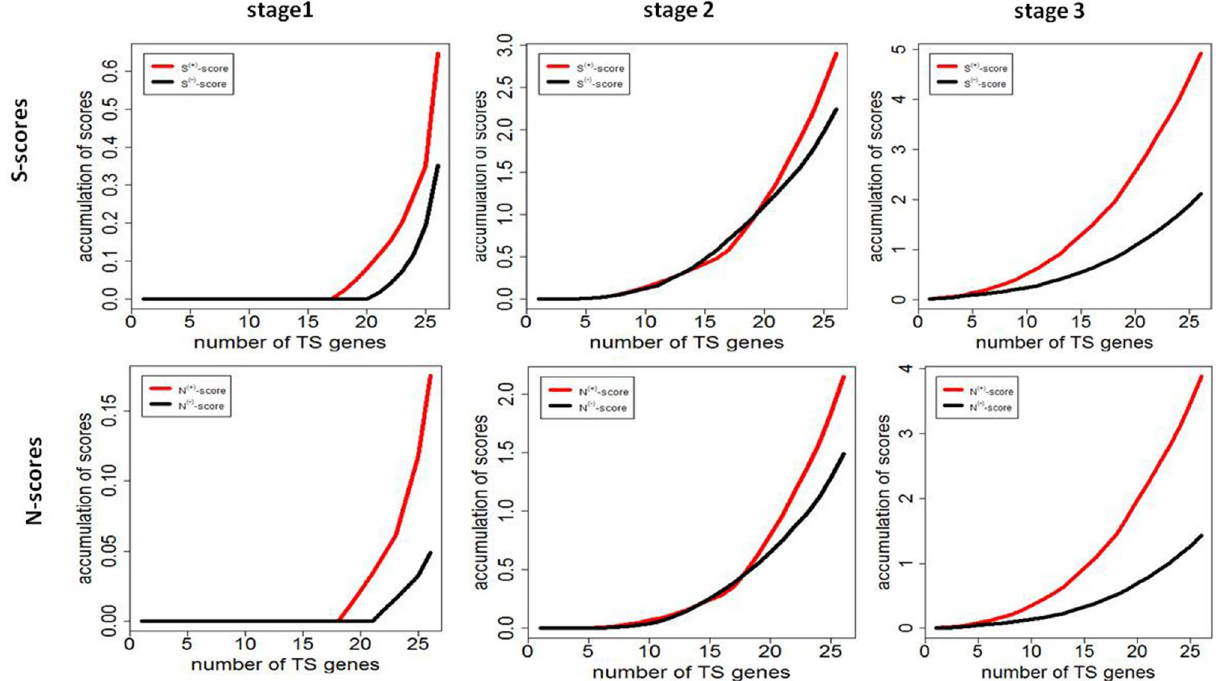
Figure 7. S + and S − and N + and N − accumulation profiles. Accumulations of S -scores and N -scores N a 1 N a 2 N a N a 1 , X a 2 N a 1 N a 2 , …, X a Y a 1 S a 1 , Y a 2 S a 1 S a 2 , …, are calculated by X a 1 n . n = + + · · · + = = + = = + a = “ + ” or “-”, N a 1 S a 1 S a 2 S a Y a N a 2 N a S a 1 S a 2 S a n where n = n and n are ranked + + · · · + ≤ ≤ · · · ≤ ≤ ≤ · · · ≤ N-score and S-score lists from the smallest to the largest. Here, 1, 2, …, n in X or Y are code for n TS genes. For S + S ( + ) 26 = S + X a 1 is N -score for the first TS gene, X a 2 is sum example, from Fig. 4, S + 1 SASH 1 at stage 2. PTCH 1 and = of N -scores for the first and second TS genes, and so on. Plot these score accumulations along numbers of TS genes to form an accumulation curve. Stages 2 and 3 are tumor stages 2 and 3. The data for calculating S -scores and N -scores are from stage2 and 3, respectively. Difference between X + and X − or between Y + and Y − may be related to development of tumor